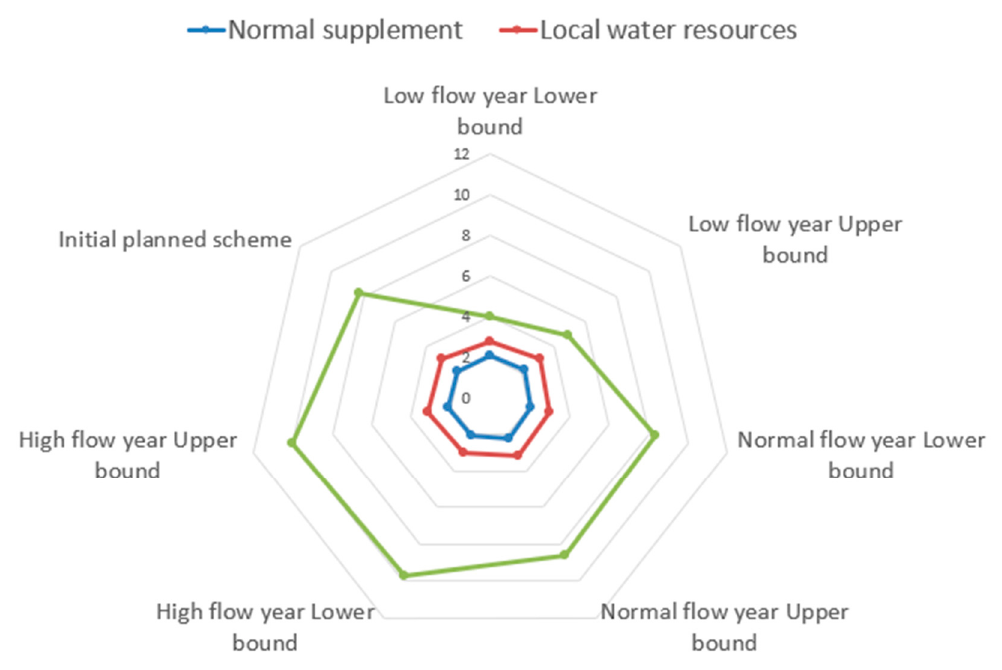
Figure 4. The water supplement amount in each scenario.